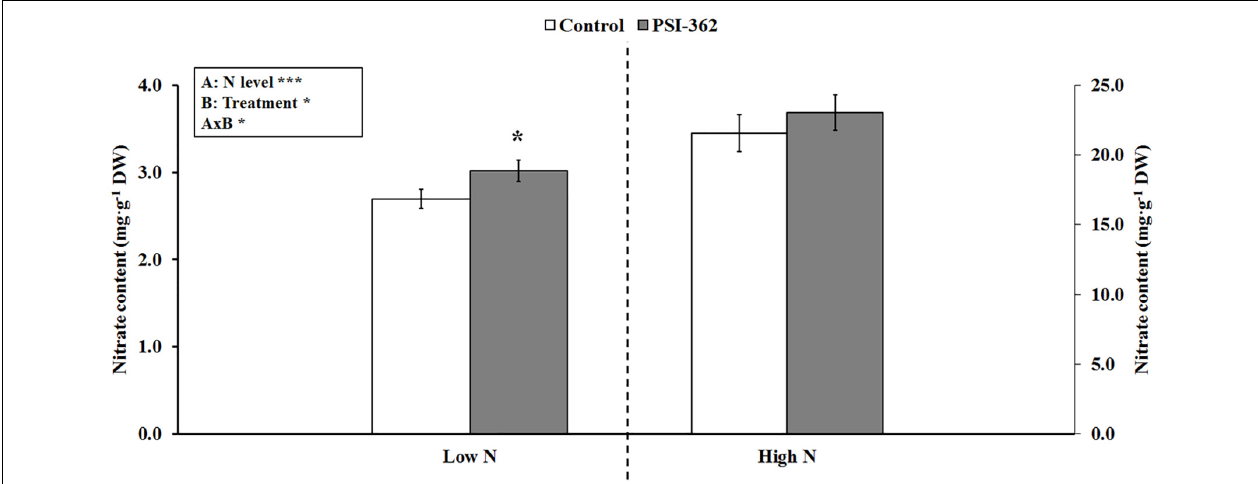
FIGURE 1 | Nitrate content in Arabidopsis seedlings. The effect of PSI-362 added by root application to Arabidopsis seedlings growing under low and high N levels (2.66 and 13.33 mM ammonium nitrate, respectively) was evaluated 6 days after application. Since interaction AxB was significant (*** p ≤ 0.001), data were subjected to t -test, comparing PSI-362 treatment versus control within the same N level. In this case, means followed by asterisk indicate statistically significant differences between control and PSI-362 treatment within the same N level (* p ≤ 0.05). Number of biological replicates ( n ≥ 4).